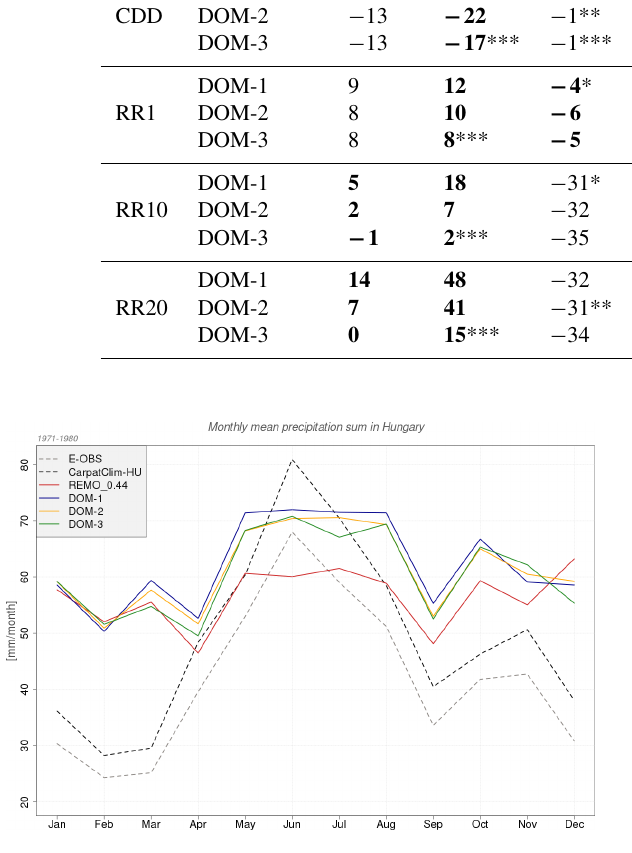
Figure 5. The average monthly precipitation amounts (mm/month) for Hungary in the period of 1971–1980 based on the results of the various REMO model simulations and the data of the CarpatClim- HU and E-OBS reference